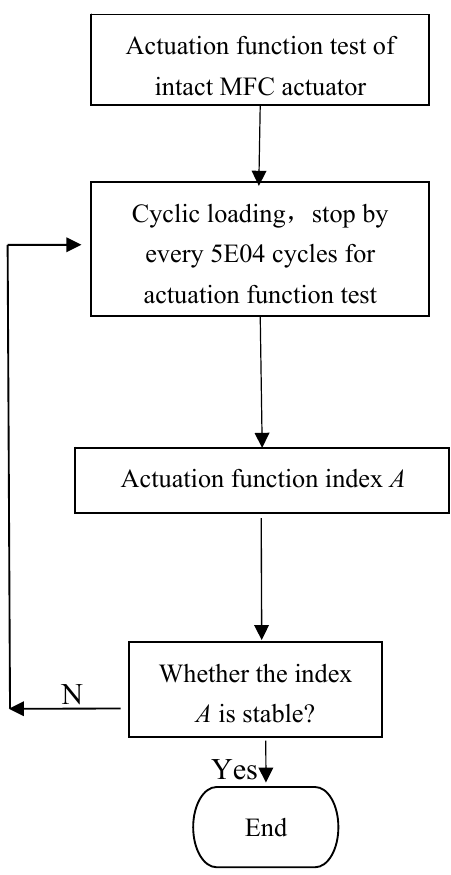
Figure 1. Flow diagram for the actuation function degradation test procedure of the Macro Fiber Composite (MFC) actuator.